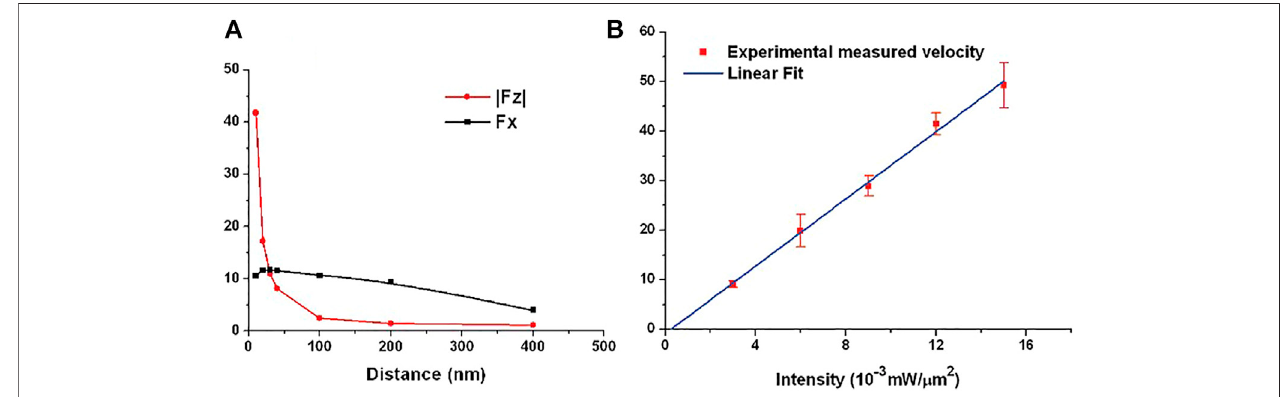
FIGURE 7 | (A) The components ofthe optical forceapplied tothe nanoparticle asa function of the distancebetween the particleand the metal substrate. (B) The velocity of the particle measured as the intensity of the incident beam changes. Complete with permission from Wang et al. (2009). Copyright 2009 American Chemical Society.